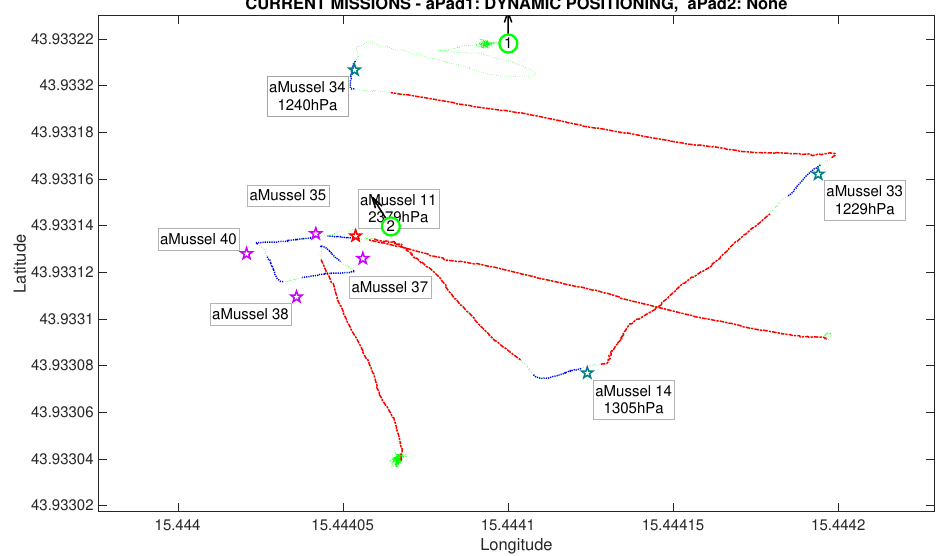
Figure 16. Second deployment completed in the Anoxia scenario experiment results from the deployment phase, reconstructed and replayed from recorded vehicle data—Biograd na Moru